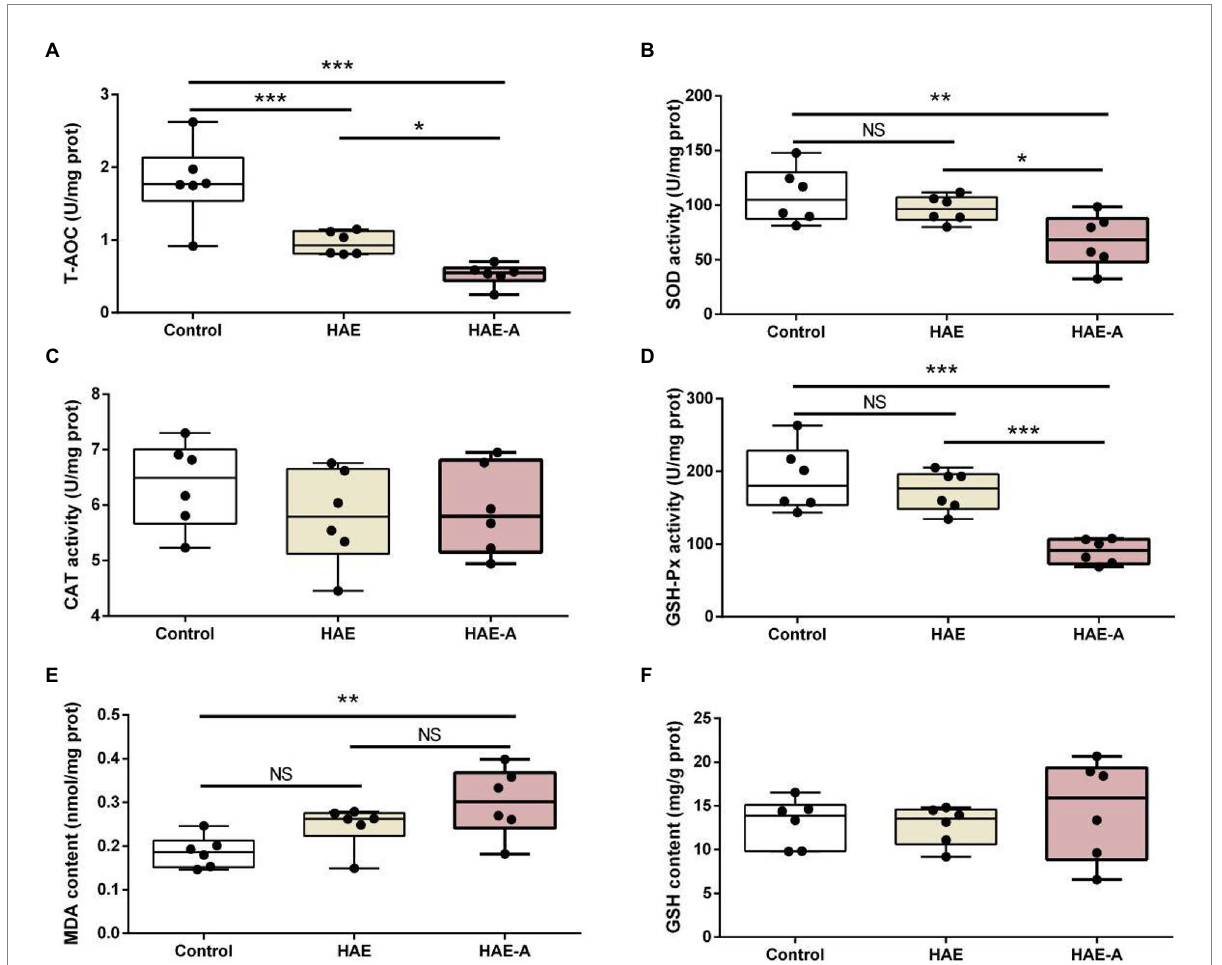
FIGURE 4 Antioxidant capacity in the prefrontal cortex. Data are presented with the means ± standard deviation ( n = 6). NS, not significant ( p > 0.05); *difference is significant at the 0.05 level ( p < 0.05); **difference is significant at the 0.01 level ( p < 0.01); ***difference is significant at the 0.001 level ( p <